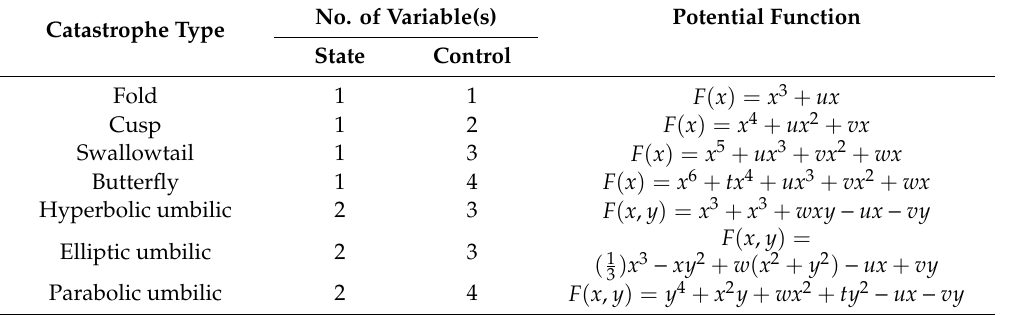
Table 1. Seven catastrophe types and their potential functions, x and y are state variables and w , t , u and v are control